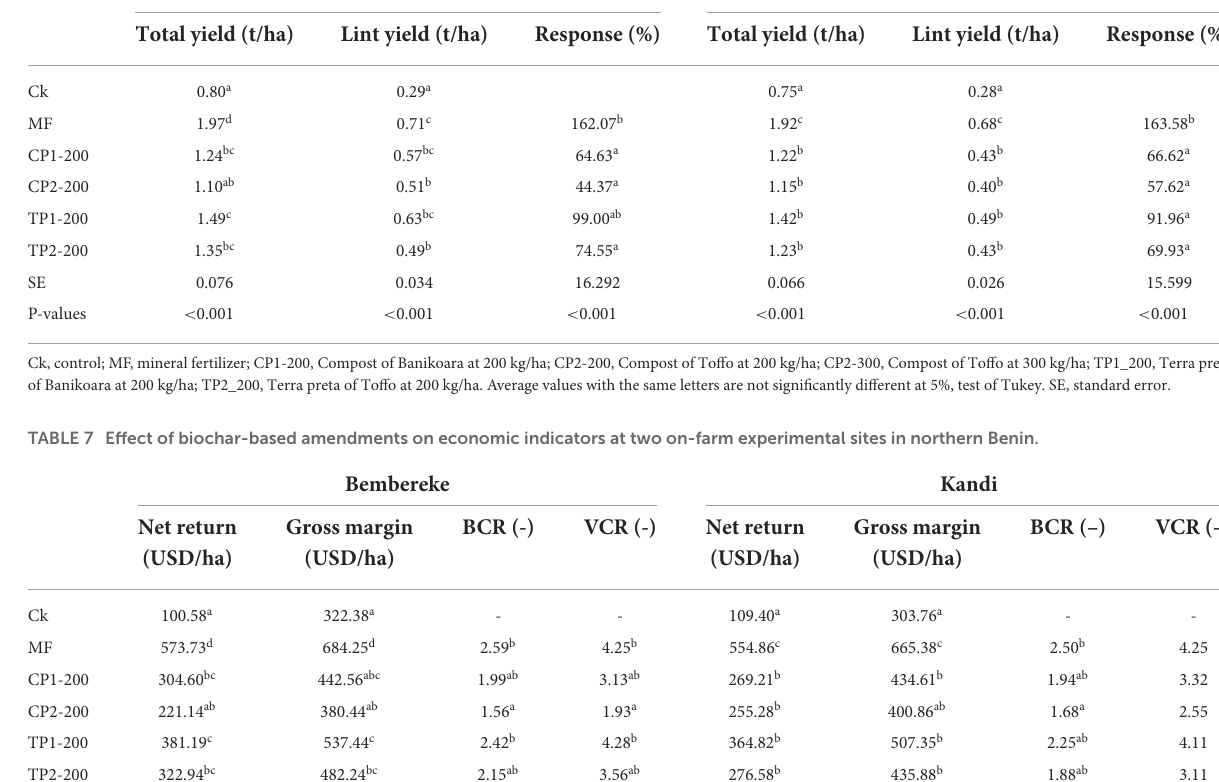
TABLE 6 Effect of biochar-based amendments on seed-cotton and lint yields at two on-farm experimental sites in northern Benin. Bembereke Kandi